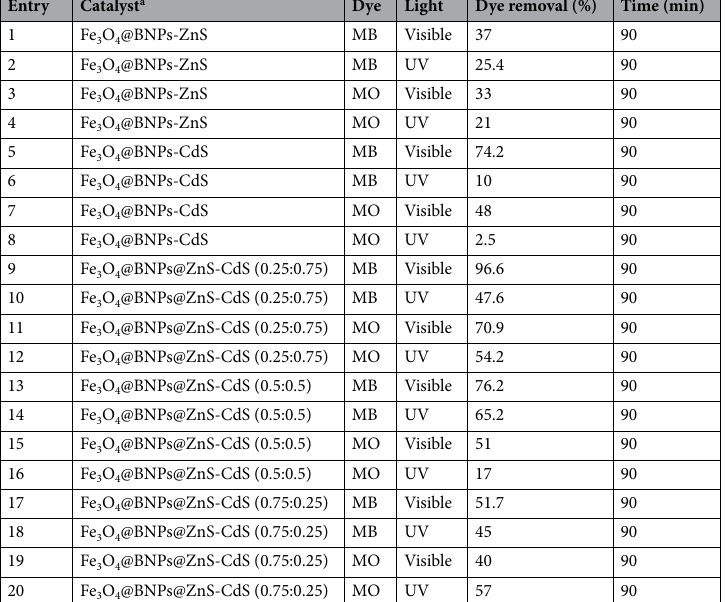
Table 2. Experiments to find the best photocatalyst in UV and visible regions. a gr of photocatalyst = 0.08 gr.